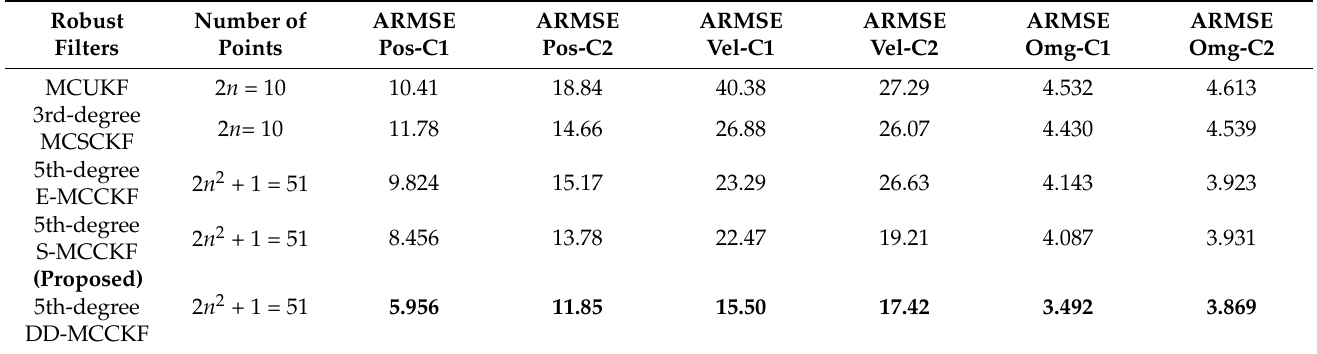
Table 4. Number of points and the ARMSEs of the position, velocity and course angular velocity for different robust filtering algorithms in the target tracking simulation of Experiment